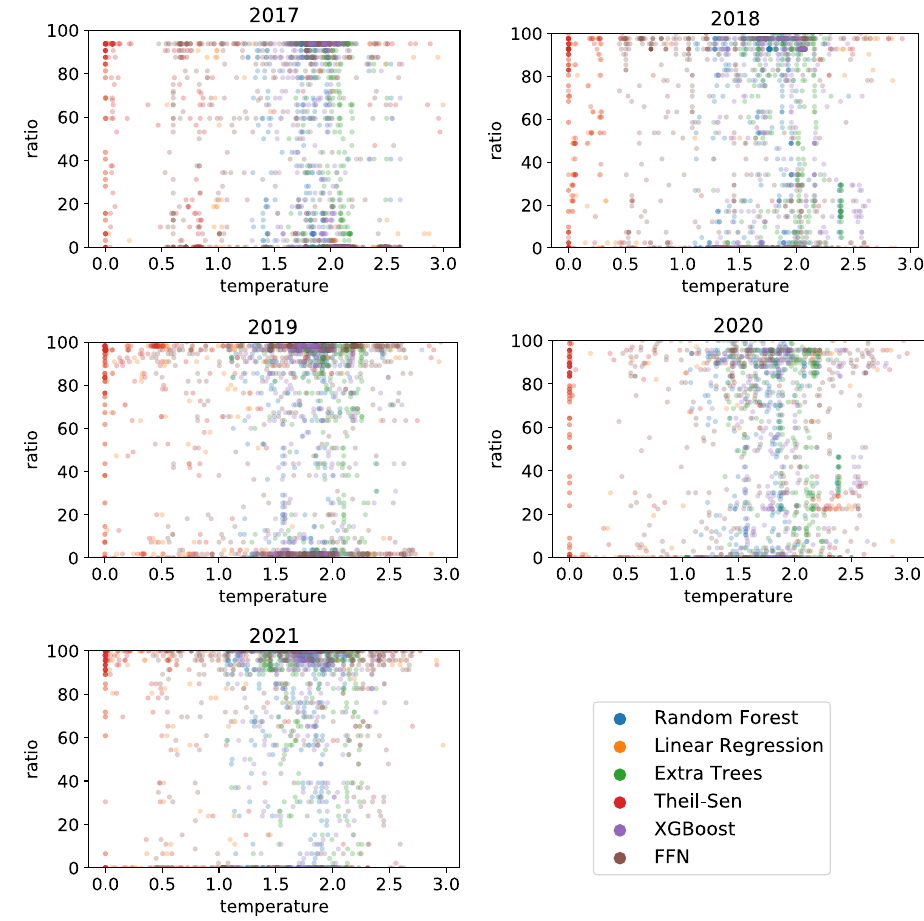
Fig. 4 Estimated temperature versus ratio of solvers submit- ted to the SAT Competitions from 2017 to 2021 solving the instances in those competitions, for several regression techniques trained baseline dataset with optimized